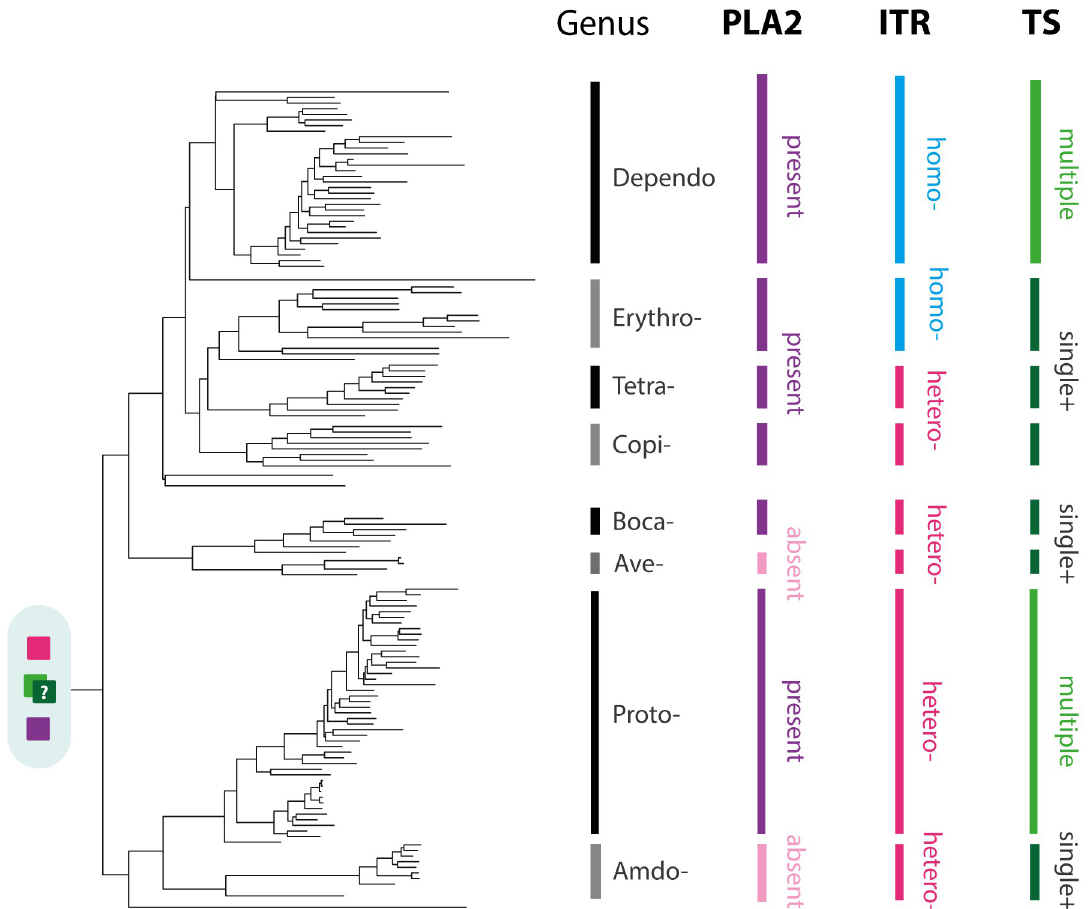
Fig 5. Conservation of genome features during Parvovirinae evolution. A midpoint rooted, ML phylogeny showing the reconstructed evolutionary relationships between contemporary parvoviruses of subfamily Parvovirinae and the ancient parvovirus species represented by EPVs. The phylogeny shown here is shown in greater detail in Fig 4. The black and grey vertical bars to the right of the phylogeny indicate parvovirus genera. Coloured bars indicate the distribution of virus traits across genera, following the key. The most likely ancestral state is indicated at the root of the tree, based on the parsimonious assumption that independent losses of genome features are more likely than independent gains. The ancestral TS remains unclear. Abbreviations : EPV, endogenous parvoviral element; Hetero, heterotelomeric; Homo, homotelomeric; ML, maximum likelihood; MTSP, multiple transcriptional start positions; STSP+, single transcription start position, plus additional strategies; TS, transcription strategy. The data underlying this figure can be found at the following DOI: https://zenodo.org/record/6968218#.Yu115vHMIUY.